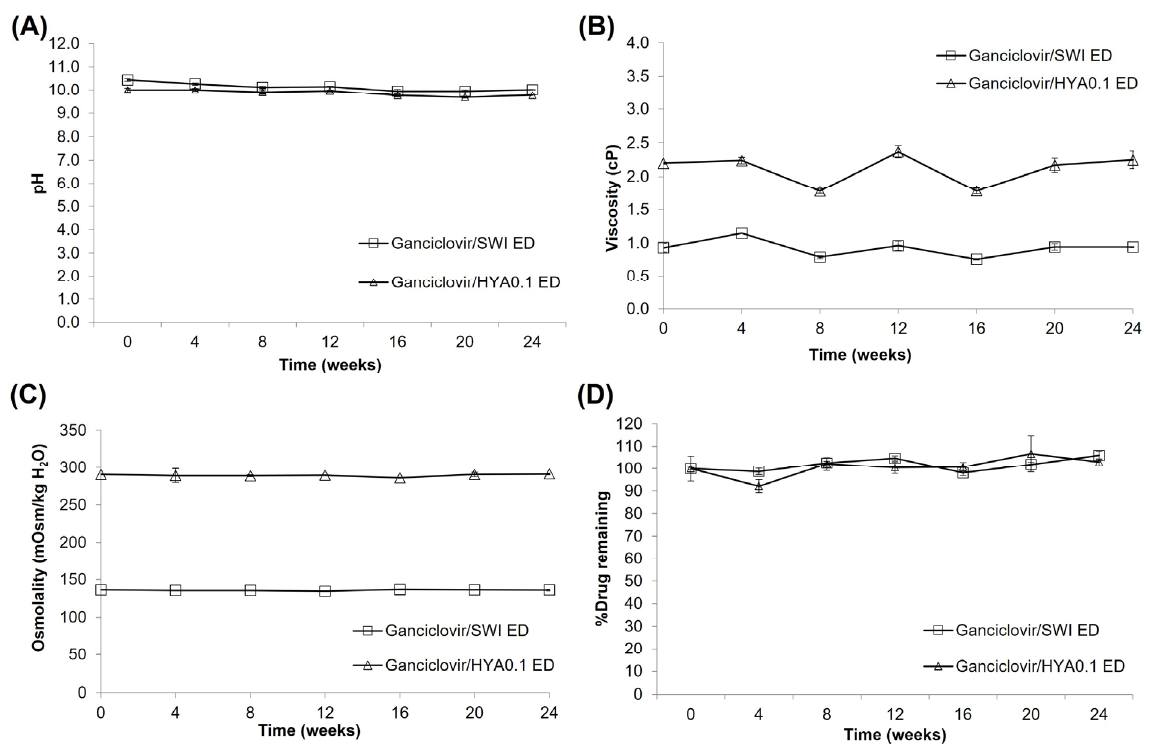
Figure 5. Stability data (pH ( A ), viscosity ( B ), osmolality ( C ), %drug remaining ( D )) of ganciclovir/HYA0.1 ED and ganciclovir/SWI ED after stored at 5 ± 3 °C for 24 weeks.